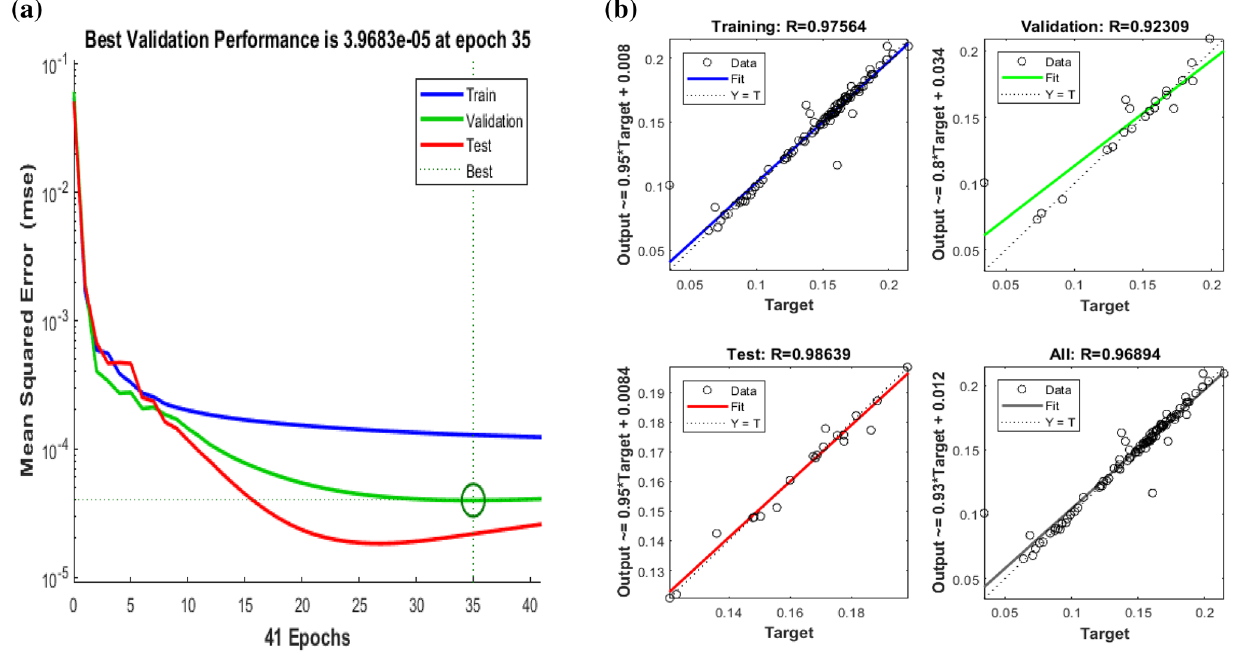
Fig. 11 Performance and regression plot of porosity ANN